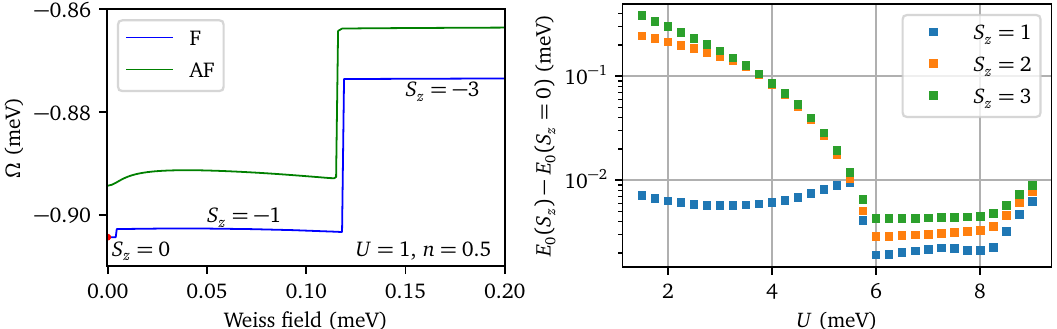
Figure 5: Left panel, blue curve: Potthoff functional vs the ferromagnetic Weiss field F for U = 1 meV, at quarter-filling. The curve is made of distinct continuous pieces, (cid:48) each associated with a value of the total spin projection S do not have zero derivative. The only solution stricto sensu is at F The green curve is the corresponding result for a Weiss field that is still ferromagnetic within layers, but antiferromagnetic between layers (it is shifted up by 0.01 meV for clarity); it has a smooth minimum at zero. Right panel: the spectral gap between the lowest-energy states for different values of total spin projection S state at S 0 for the quarter-filled cluster, as a function of U . Note the logarithmic z = scale. The spectral gap becomes very small after U towards ferromagnetism. In each case the chemical potential µ and its cluster value were set so as to sit precisely at quarter µ (cid:48)